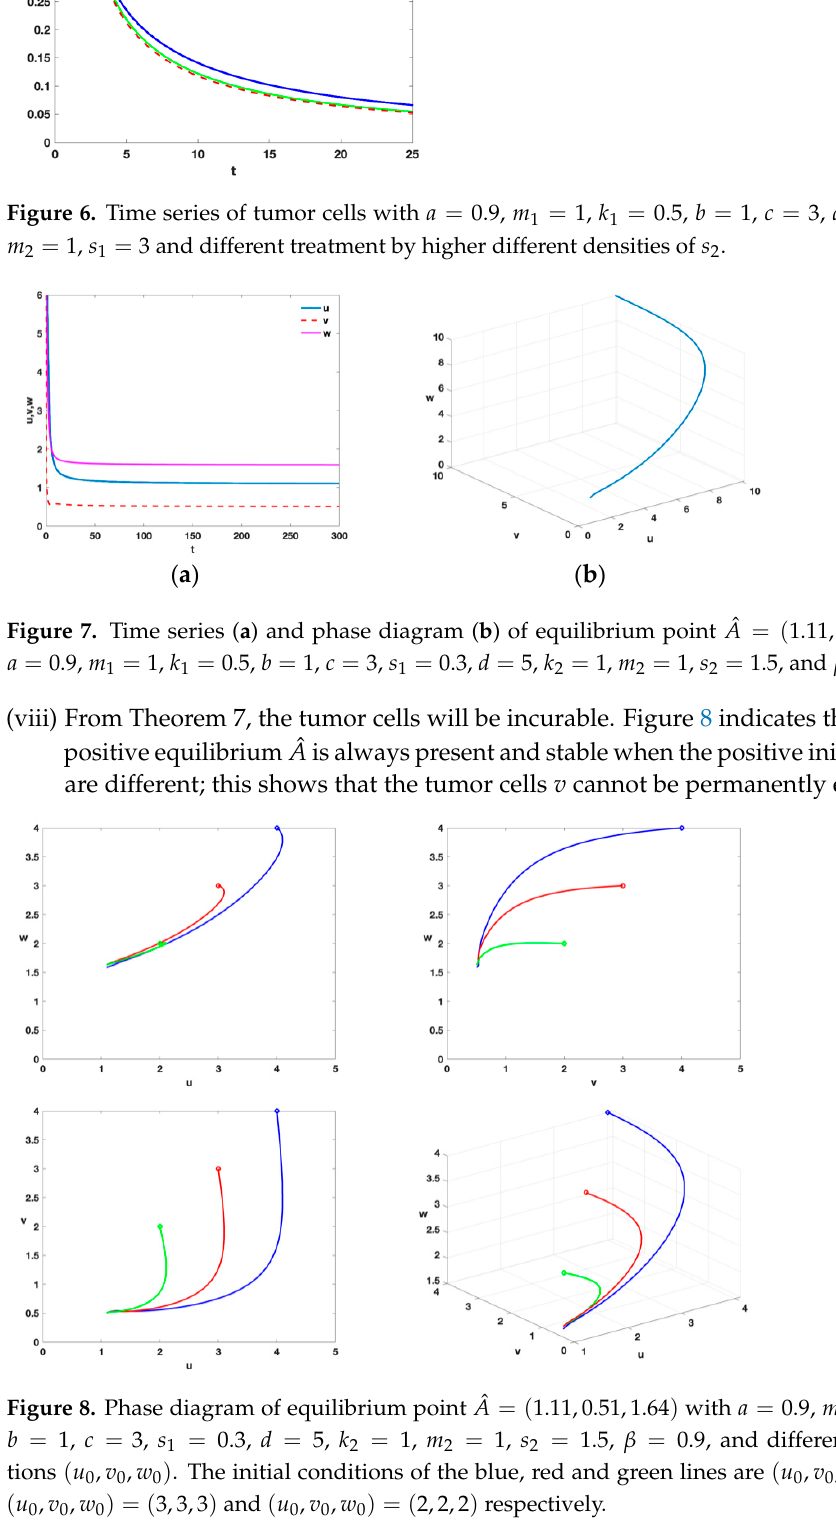
tions ( u 0 , v 0 , w 0 ) . The initial conditions of the blue, red and green lines are ( u 0 , v 0 , w 0 ) = ( 4,4,4 ) , . The initial conditions of the blue, red and green lines are  ( u ) = ( 3,3,3 ) and ( u ) = ( 2,2,2 ) 0 , v 0 , w 0 0 , v 0 , w 0